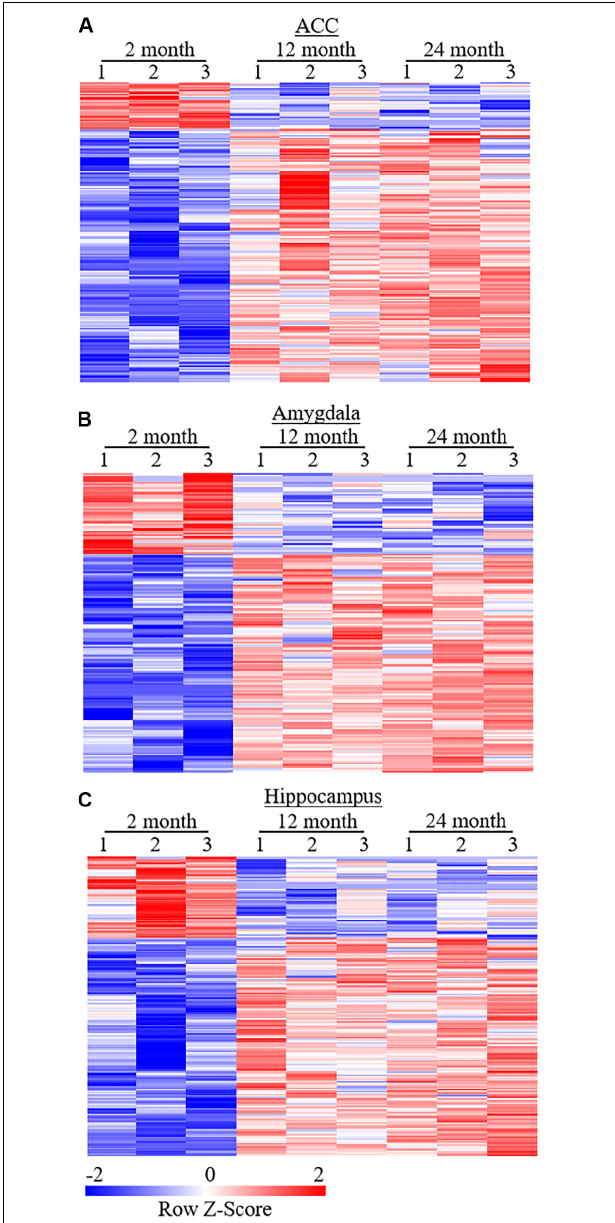
FIGURE 5 | Heatmaps of differentially expressed genes (DEGs) in the ACC (A) , amygdala (B) , and hippocampus (C) from both 12- and 24-month old mice versus 2-month old mice. Colors in the heatmaps indicate the Row Z -score among the different data sets. High expression is shown by the red color spectrum, and low expression is shown by the blue. N = 3 biological repeats (3 mice)/age.